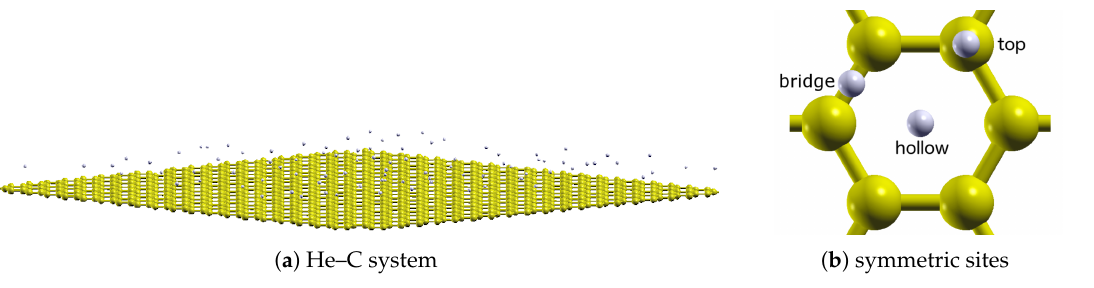
Figure 1. ( a ) A cutaway of graphene and adsorbed helium atoms. A single layer is shown, but up to 16 (as an approximation to graphite) are considered in this work. ( b ) High-symmetry sites over the graphene plane. These will be referred to as the hollow, bridge, and top sites. Note that these results were calculated using the helium–helium (He–He) potential of Przybytek et al. and the isotropic helium–carbon (He–C) potential (discussed in Section 2).